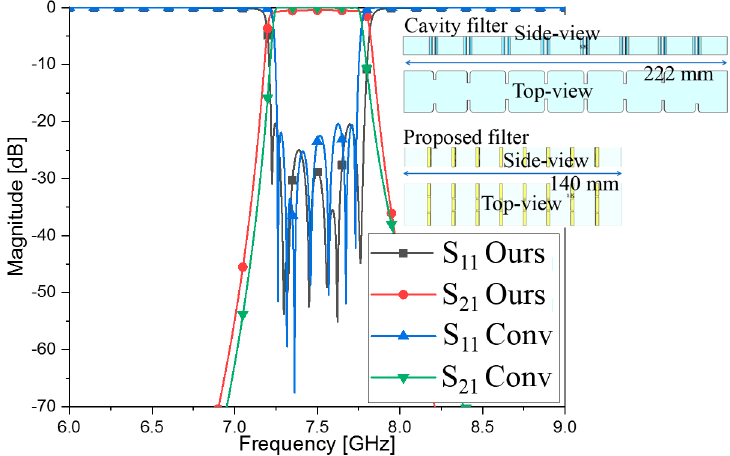
Figure 10. Comparing the proposed filter and nonmetamaterial filter with respect to geometries and frequency responses.